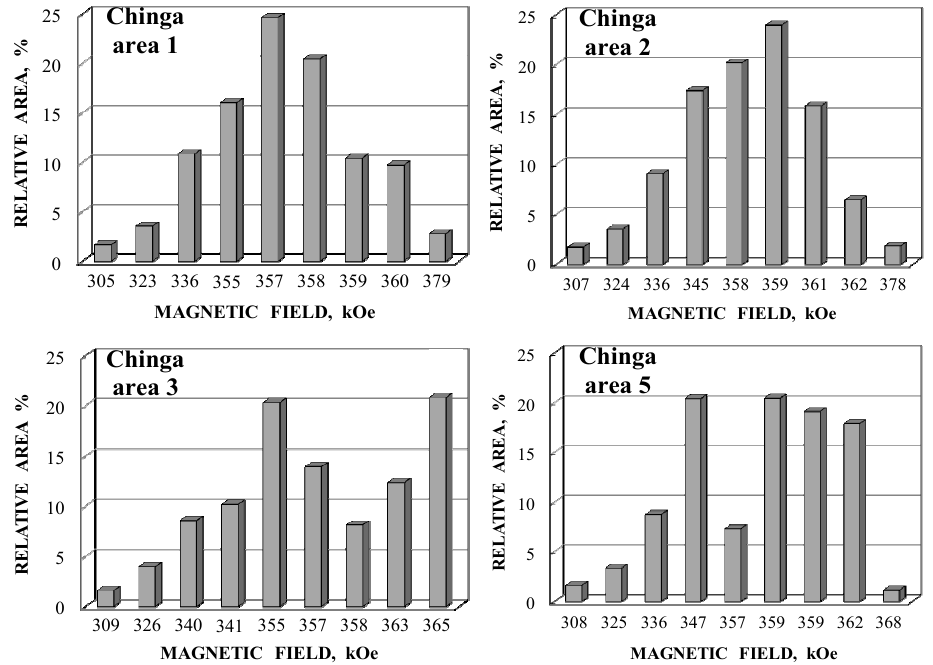
Figure 32. Comparison of histograms of the magnetic hyperfine field distributions obtained from decomposition of the Mössbauer spectra of Chinga meteorite samples shown in Figure 31. Adapted from Ref. [80].